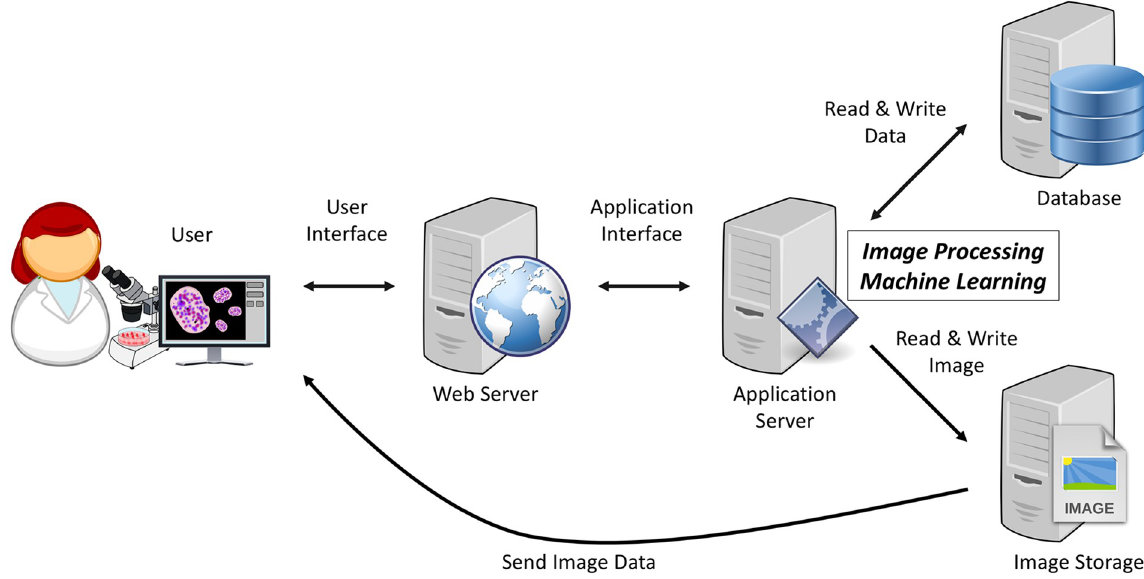
Fig 1. Architecture of IMACEL, a cloud-based image processing and machine learning platform for life science researchers. The entire process of image processing is performed in the cloud using high-performance virtual machines. The public-domain images used in this figure were obtained from